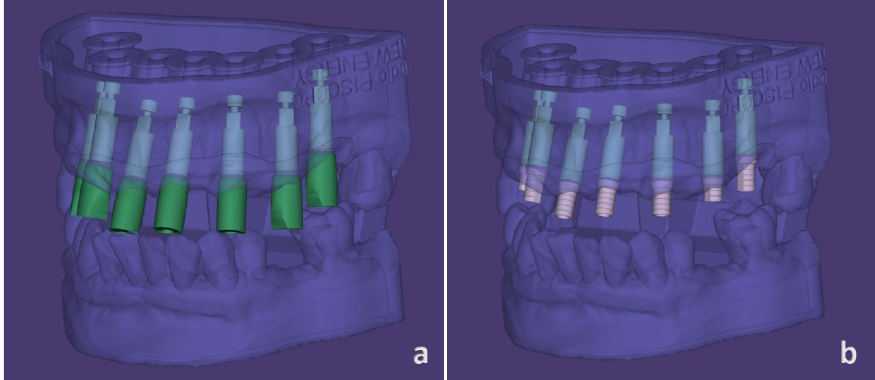
Figure 6. Virtual presurgical impression on the scan abutment library file ( a ) and related extragrade abutments for OT-Bridge system ( b ).